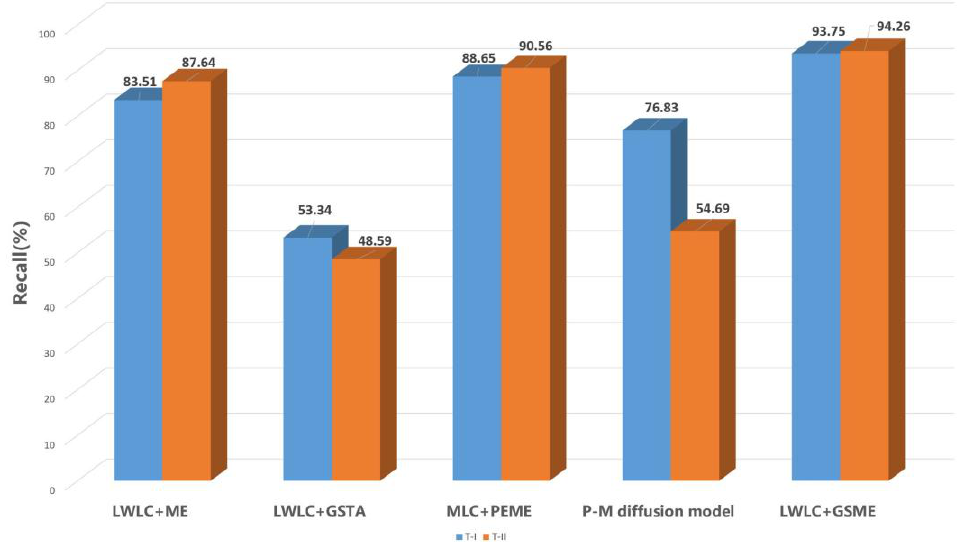
Figure 13. Comparison of defection recall for four detection methods. The blue block and orange block denotes T-I defect and T-II defect, respectively.